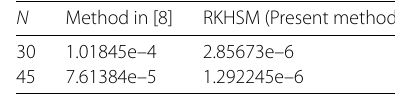
Table 1 Maximum absolute error for Example 1 ( n = 7)